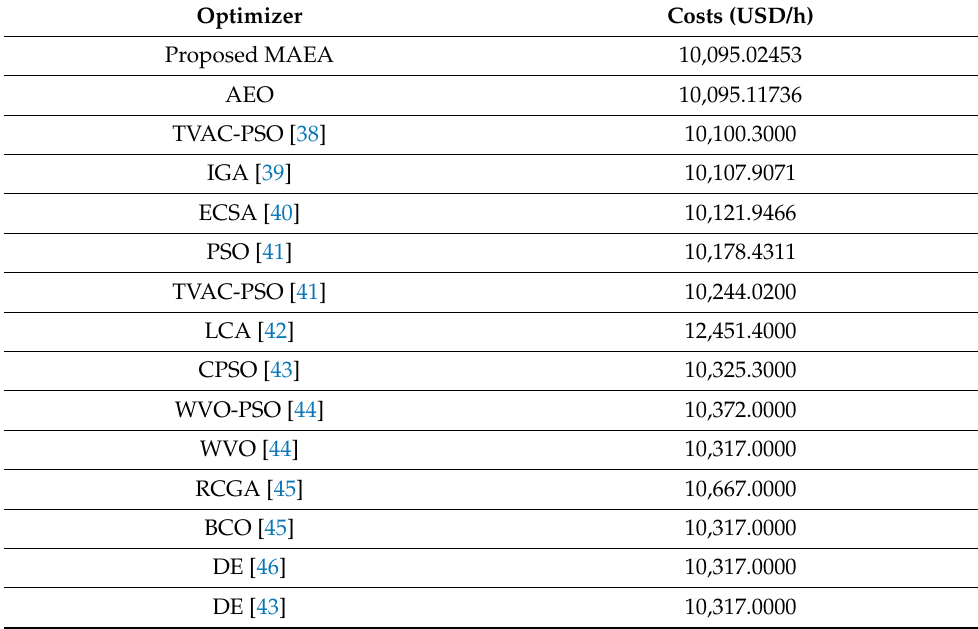
Table 5. Comparative Results for Case 2 for the 7-Unit